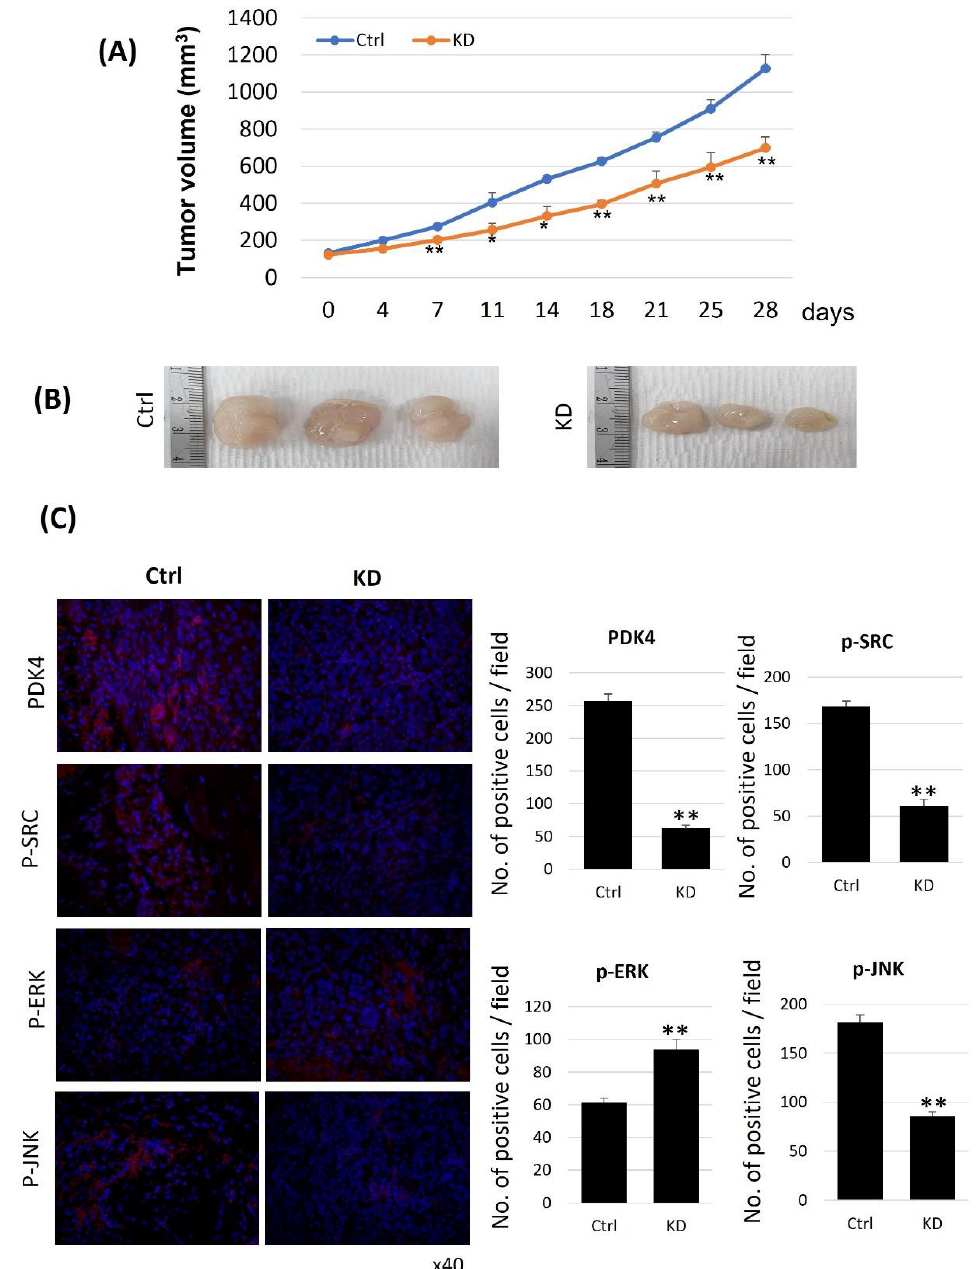
Figure 4. Xenograft model of PDK4 knockdown J82 cells. ( A ) Tumor growth. (* p < 0.05, ** p < 0.01 Day 0 vs. Each day). Ctrl: wild type, KD: knockdown. ( B ) Gross appearance. ( C ) Representative image of immunohisto-chemistry. (* p < 0.05, ** p < 0.01 Ctrl vs. KD).